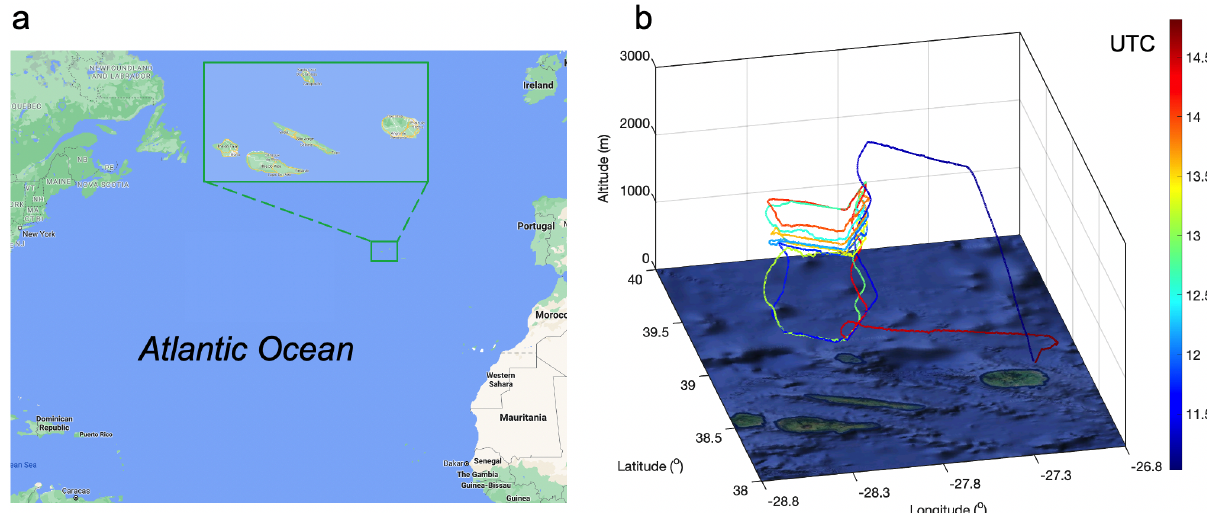
Figure 2. (a) The geographical location of the ACE-ENA campaign. (b) An example of a representative flight pattern on 25 January 2018. The G-1 flew an L-shaped pattern consisting of along-wind legs upwind of Graciosa Island and cross-wind legs over the ocean. Maps are obtained from © Google